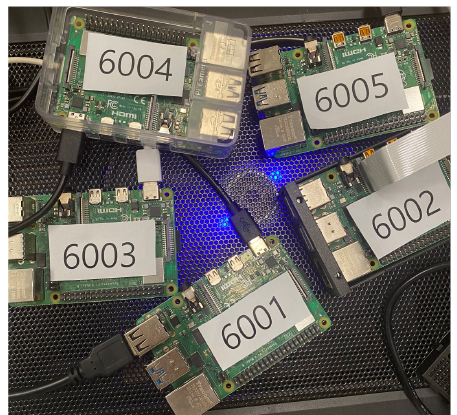
Figure 9. IoT device for IoT-Chain network configuration.